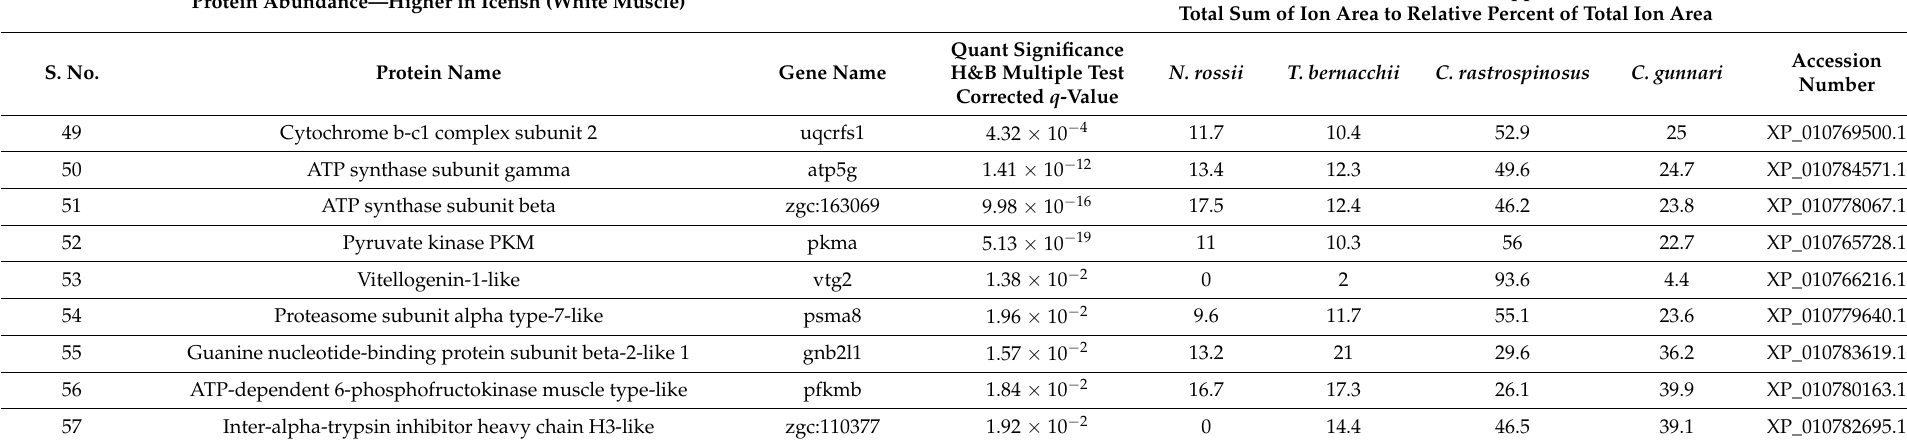
Table 2. Cont. Protein Abundance—Higher in Icefish (White Muscle)